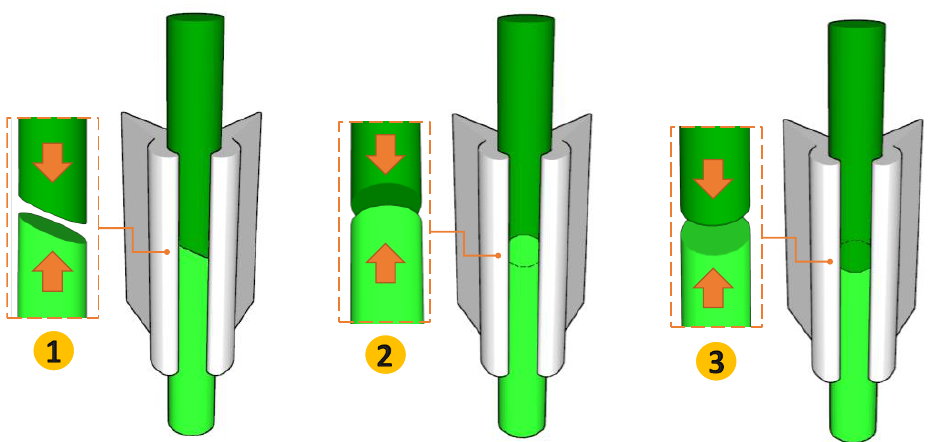
Figure 5. Outline of the orientation combinations between grafted seedlings regarding the grafting clip. ① Profile union surface (S). ② Union surface with the rootstock forward (FR). ③ Union surface with the scion forward (FS).